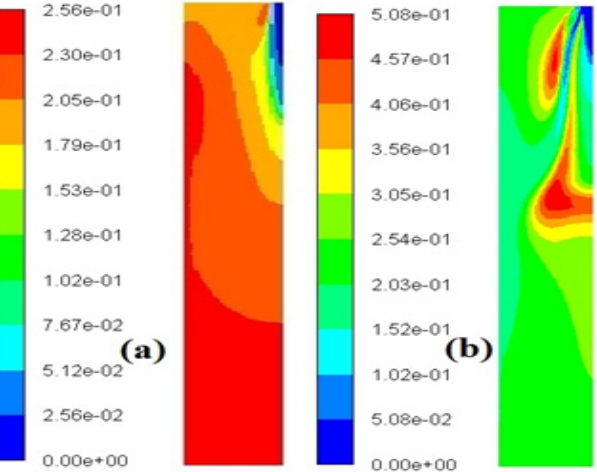
Figure 30. Contours of H 2 O vapor content in mole fraction where the right vertical line represents the axis of symmetry: ( a ) Reactor 1 and ( b ) Reactor 2.